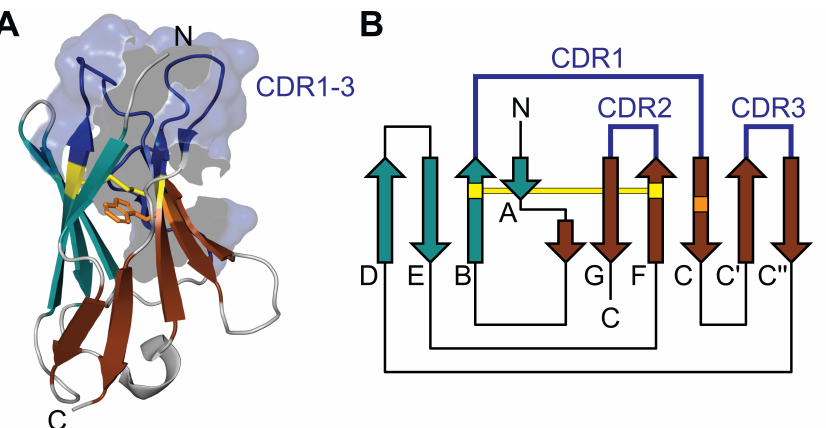
Figure 1. Structure of a light chain V-domain. ( A ) Three-dimensional structure (PDB entry: 6MH2) and ( B ) two-dimensional topology diagram of a natively folded V-domain. The Greek-key β - sandwich is formed by two antiparallel beta sheets consisting of strands ABED (cyan) and CC (cid:48) C”FG (brown). The three CDR loops (blue) cluster on the same side of the structure and form the antigen binding site. The conserved disulfide bridge (yellow) and tryptophan (orange) are highlighted. N: amino terminus; C: carboxy